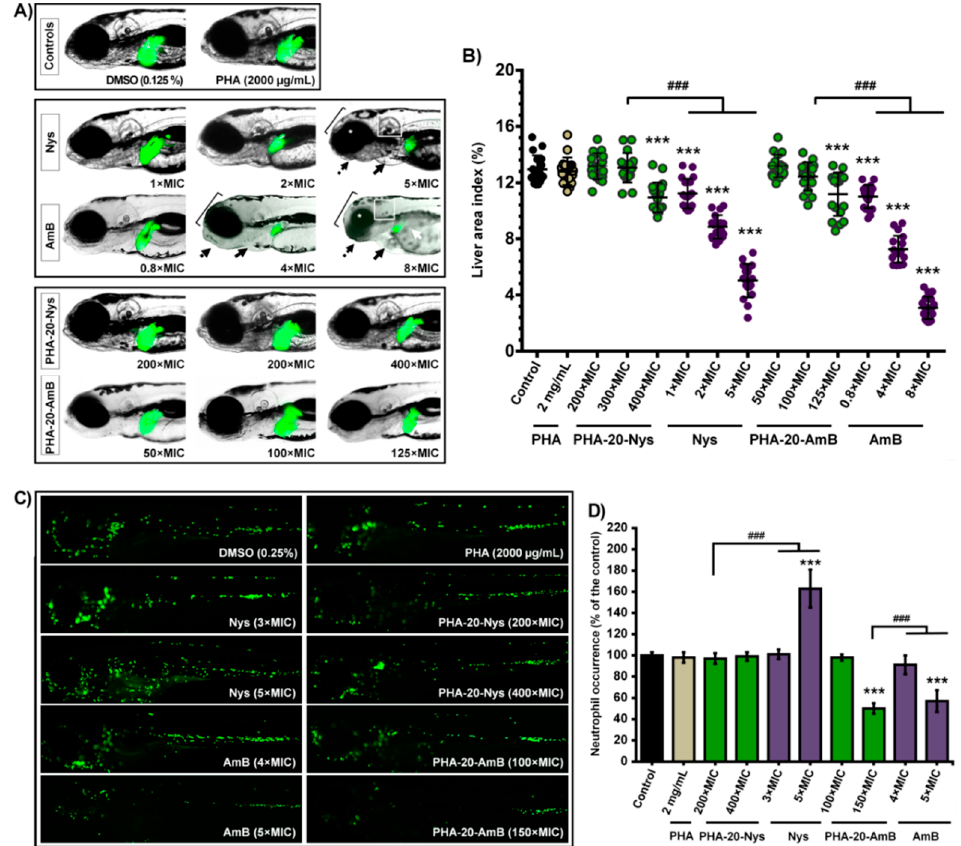
Figure 4. Dose-dependent hepatotoxicity ( A , B ) and myelotoxicity ( C , D ) of the pure biopolymer (PHA), free polyenes (Nys and AmB) and biopolymer-based polyene formulations (PHA-20-Nys and PHA-20-AmB). Changes in the liver size and fluorescence ( A ) and in the liver area index ( B ) as a function of the treatment type and concentration are shown. Hepatotoxicity endpoints (decreased liver area index, dark liver and reduced yolk consumption) have not been observed in the fish exposed to 2000 µ g/mL of PHA, 1500 µ g/mL of PHA-20-Nys (300 × MIC) and 100 µ g/mL of PHA-20-AmB (100 × MIC). Conversely, free drugs Nys and AmB reduced the LA index at the therapeutic (1 × MIC, 1 µ g/mL) and sub-therapeutic (0.2 µ g/mL, 0.8 × MIC) doses ( p < 0.001), respectively, as well as the yolk consumption at higher doses (white arrow). Additionally, free polyenes caused various skeletal deformities such as the malformation of head (bracket), jaw (dashed arrow), eyes (asterisk) and otoliths (boxed), and an appearance of pericardial edemas (arrow) at the higher therapeutic doses ( ≥ 4 × MIC for AmB and ≥ 5 × MIC for Nys). AmB was much more hepatotoxic, cardiotoxic and teratogenic then Nys. Distribution of the fluorescently labeled neutrophils upon different treatments ( C ) and the neutrophil occurrence in zebrafish embryos ( D ) are shown. Both polyenes were myelotoxic at the higher therapeutic doses, where AmB caused neutropenia ( ≥ 5 × MIC) and Nys inflammation ( ≥ 5 × MIC). On the other side, neither PHA nor polyene-loaded PHA microsphere caused the myelotoxic response. Statistically significant differences in the liver area index values between the control (DMSO) group and the treated groups (*** p < 0.001), as well as between the groups exposed to free polyenes and the respective polyene-loaded microspheres (### p < 0.001) are